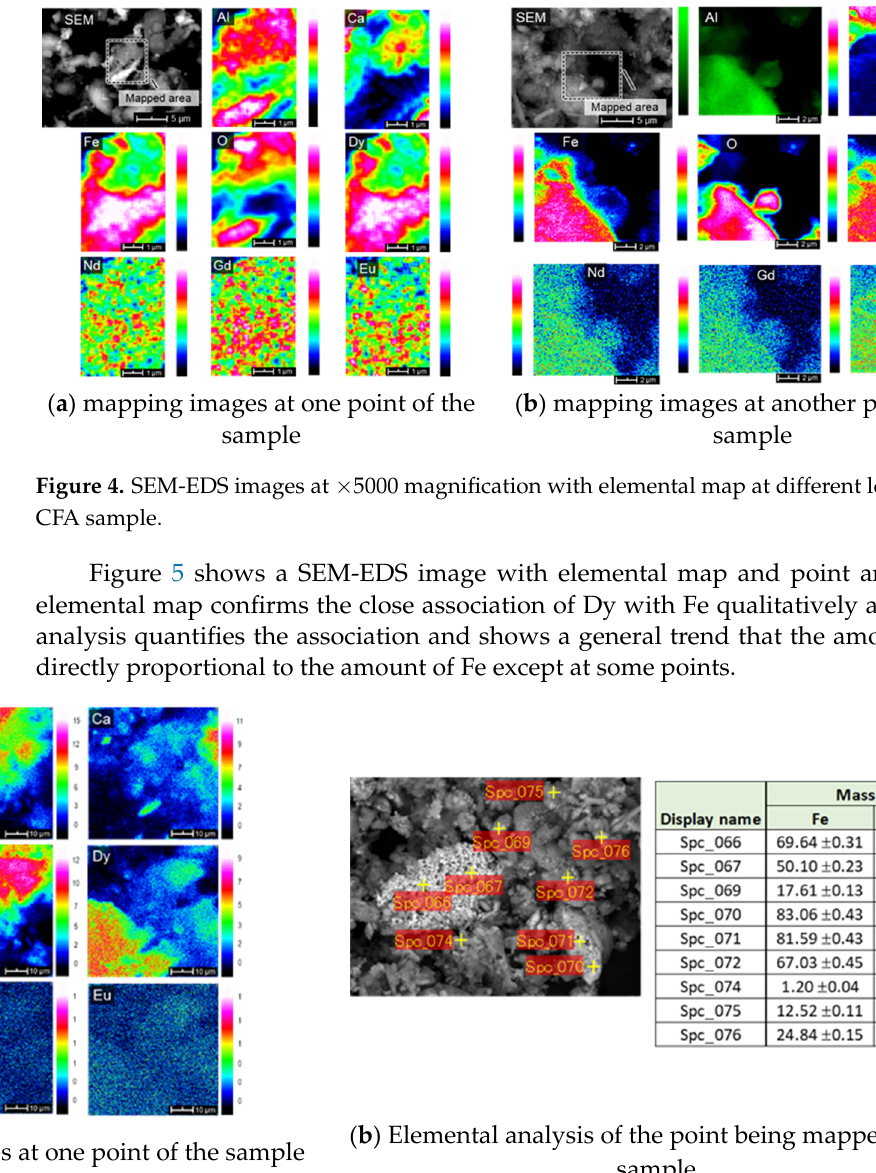
Figure 5. SEM-EDS image at ×2300 magnification with elemental map and point analysis.